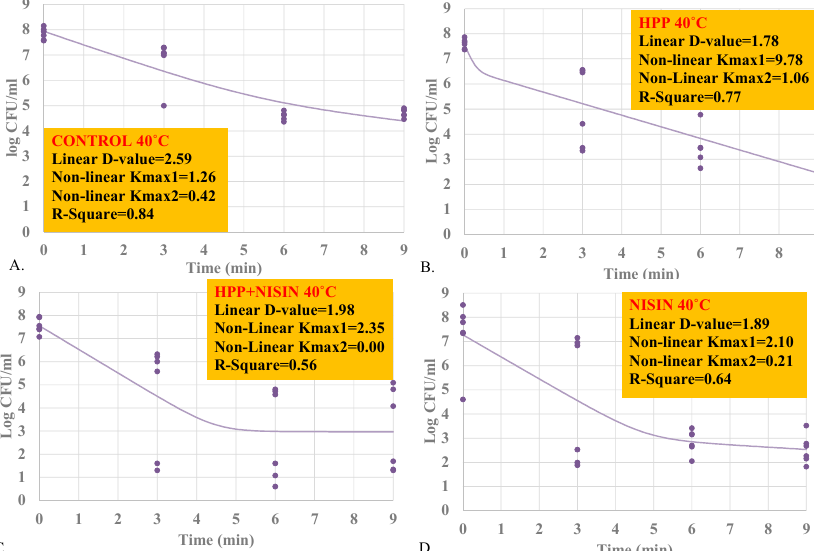
Figure 3. Linear and nonlinear inactivation indices for four-strain cocktail of L. monocytogenes (ATCC @ 51772, 51779, BAA-2657, and 13932) in sterilized phosphate-buffered saline, treated by nisin (5000 IU/mL) and/or elevated hydrostatic pressure at 400 MPa (Barocycler Hub880 Explore, Pressure Bioscience Inc., Easton, MA, USA) at 4 °C. ( A ) Treated by hydrostatic pressure at 400 MPa (58 K PSI) at 4 °C; ( B ) Treated by hydrostatic pressure at 400 MPa (58 K PSI) and exposed to nisin (5000 IU/mL) at 4 °C; ( C ) Exposed to nisin (5000 IU/mL) at 4 °C.